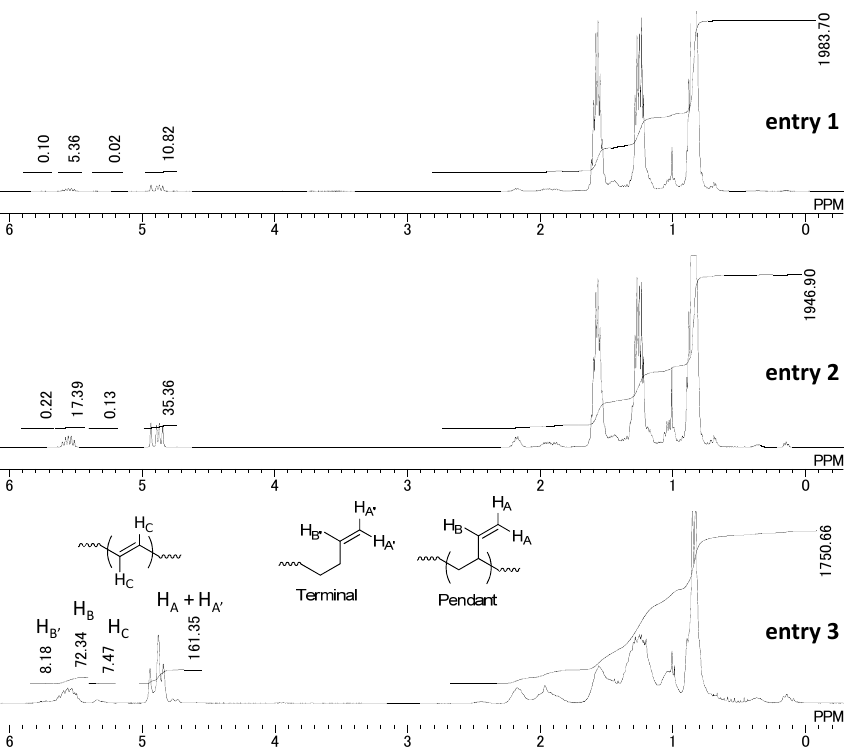
Figure 5. 1 H-NMR spectra of the propylene/butadiene copolymers obtained from the runs 1, 2, and 3 of Table 2.